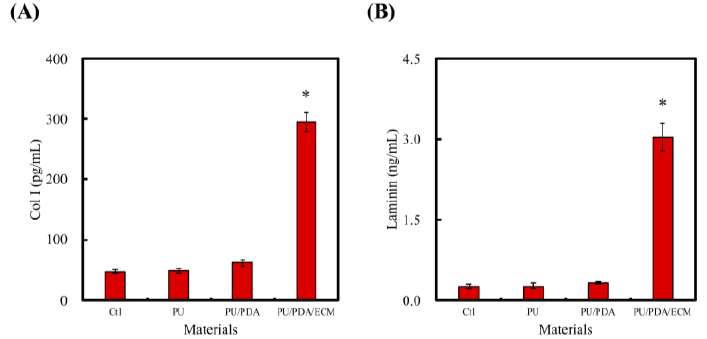
Figure 7. ( A ) Col I (type I collagen) and ( B ) laminin were released from PU, PU/PDA, and PU/PDA/ECM conduits in DMEM extracts. * indicates a significant difference ( p < 0.05) compared to Ctl (control).